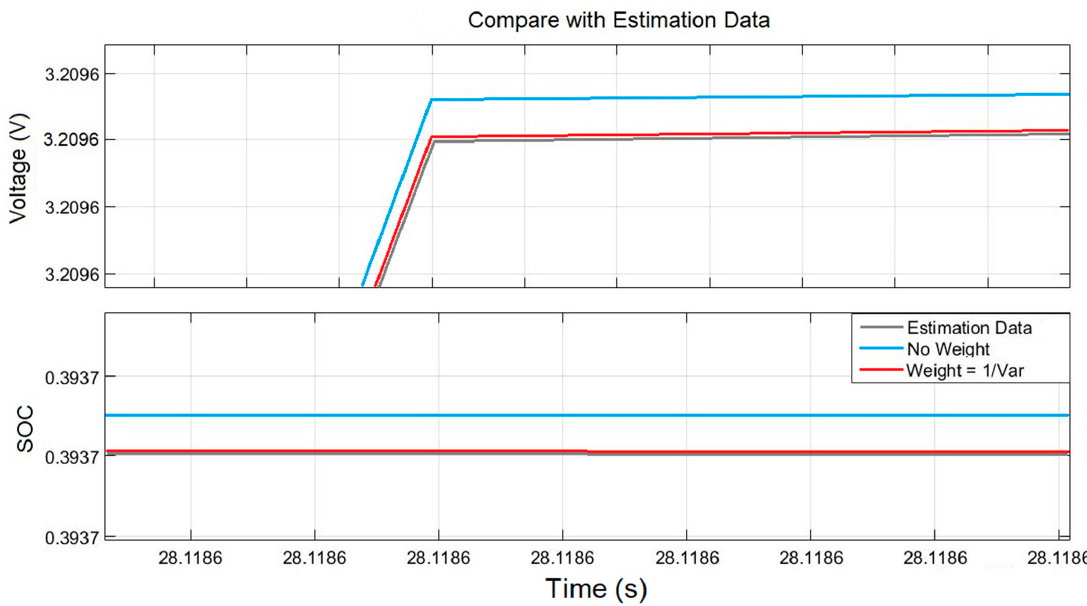
Figure 6. Comparison with the two-outputs nonlinear grey box model estimation data with the best experiment—amplified signal.